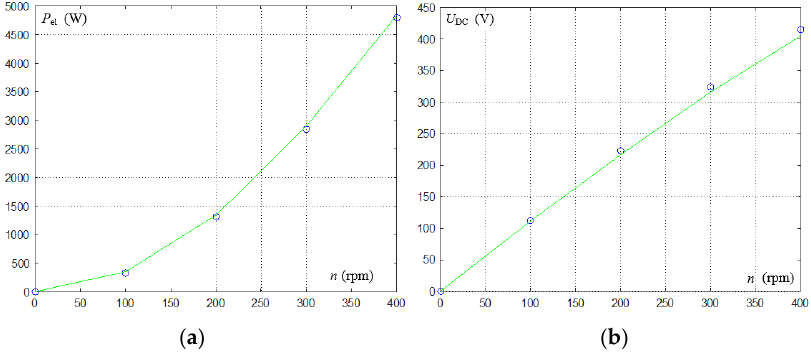
Figure 28. Generator G2: ( a ) voltage changes with the rectifier load; ( b ) electric power changes with rectifier load; for selected rotational values, points-measurement results, solid line-analytical calculations. Core generator with simple magnets-G3